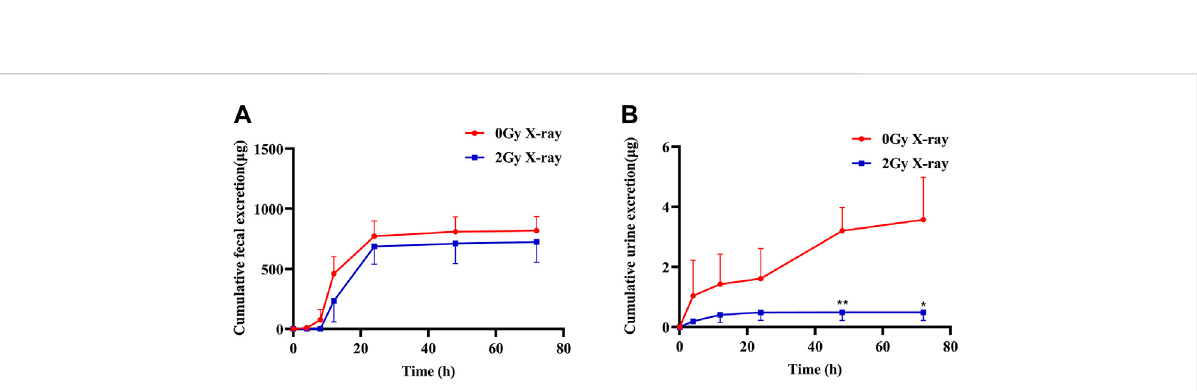
FIGURE 4 The mean cumulative fecal (A) and urine (B) excretion of apatinib in rat presence or absence abdominal X-ray irradiation after intragastrical administration of 45 mg/kg (Mean ± SD, n = 3). The t -test was used for data analysis between the two groups. * signi fi cantly different from